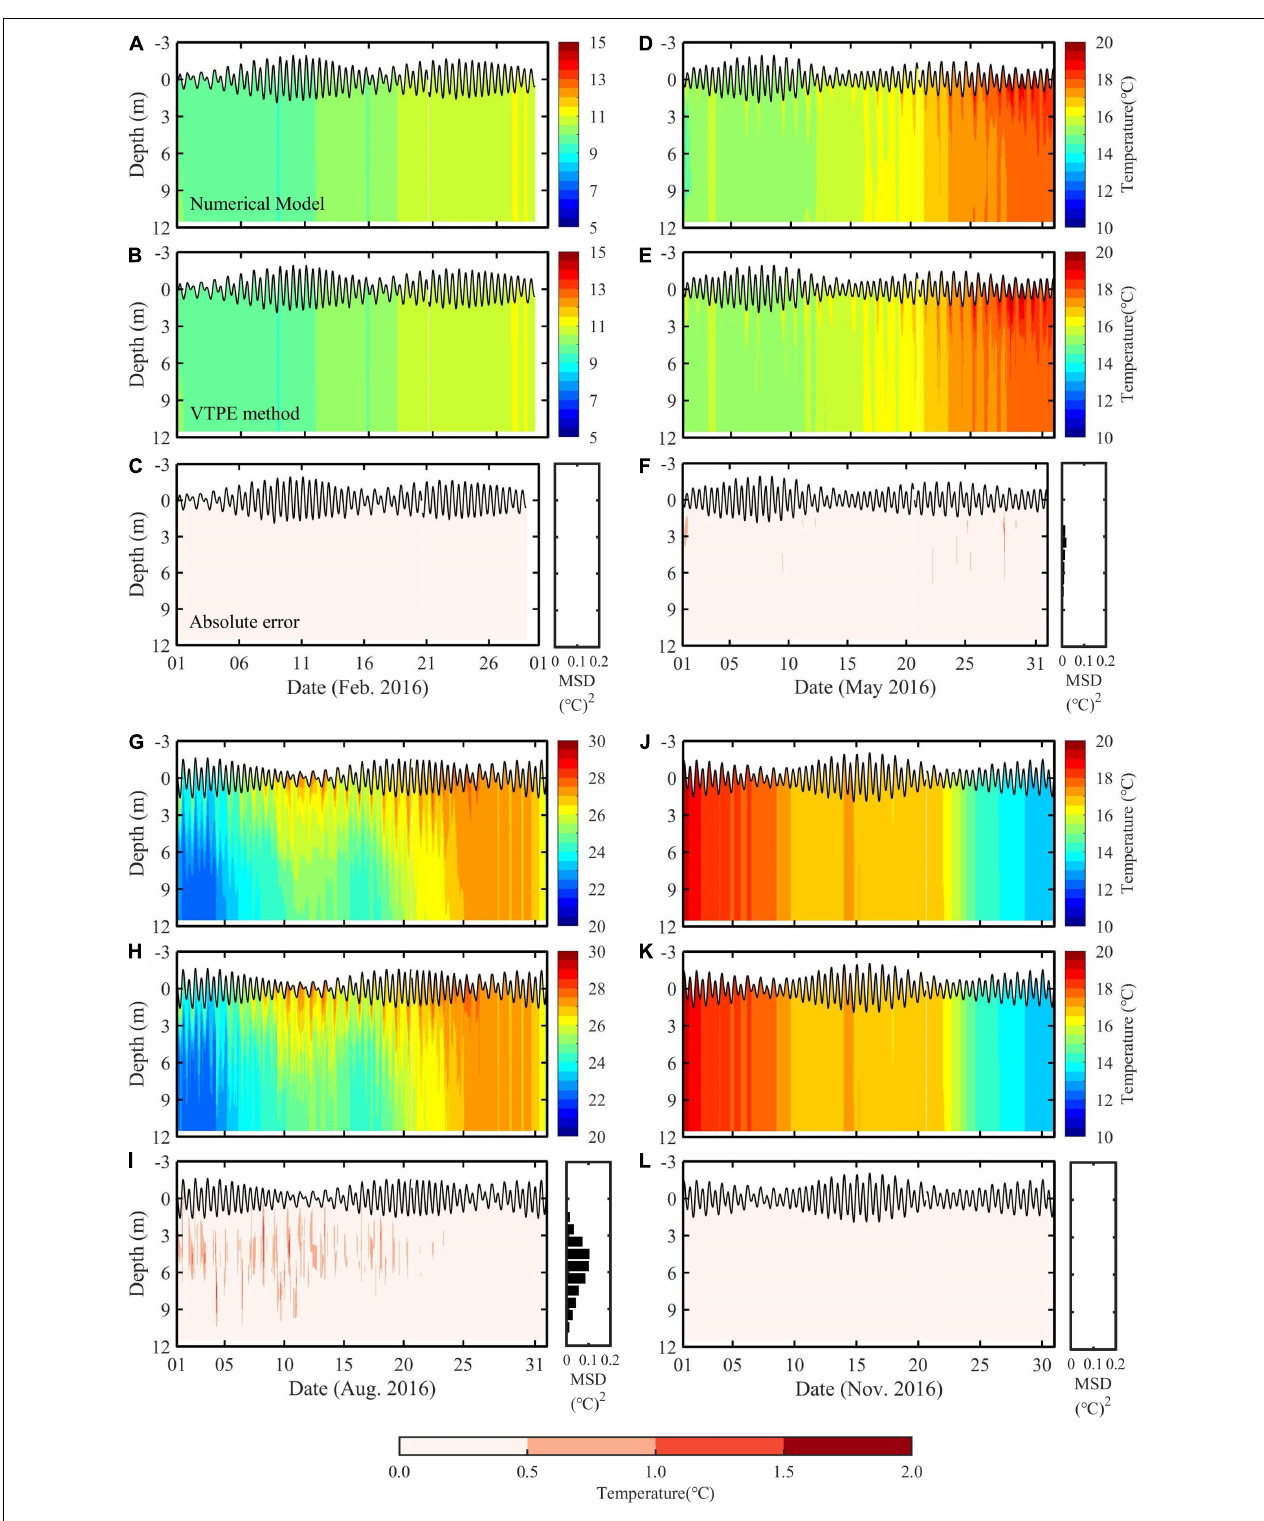
FIGURE 3 | (A,D,G,J) Timeseries of temperature profiles obtained as output of the numerical model for February, May, August, and November 2016 together with the sea level modulations. (B,E,H,K) Timeseries of temperature profile estimated from the VTPE method. (C,F,I,L) Absolute errors in temperature between the output of the numerical model and VTPE results. The colorbar for absolute errors is shown at the bottom. Histograms on the right of (C,F,I,L) represent the vertical distribution of MSD [( ◦ C) 2 ] in the water column at 1-m intervals.